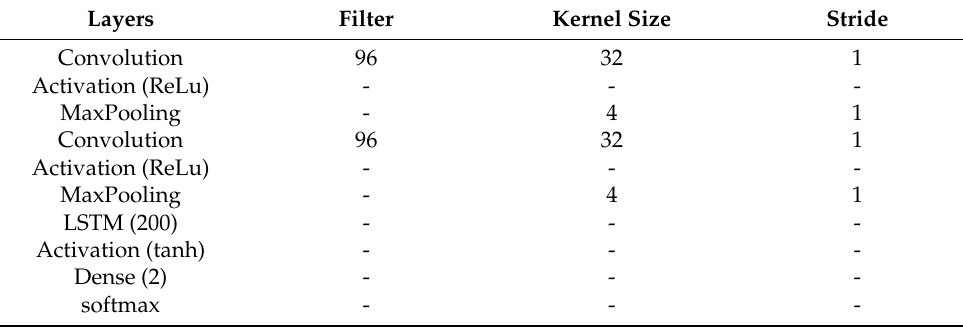
Table 1. Architecture of proposed C-LSTM